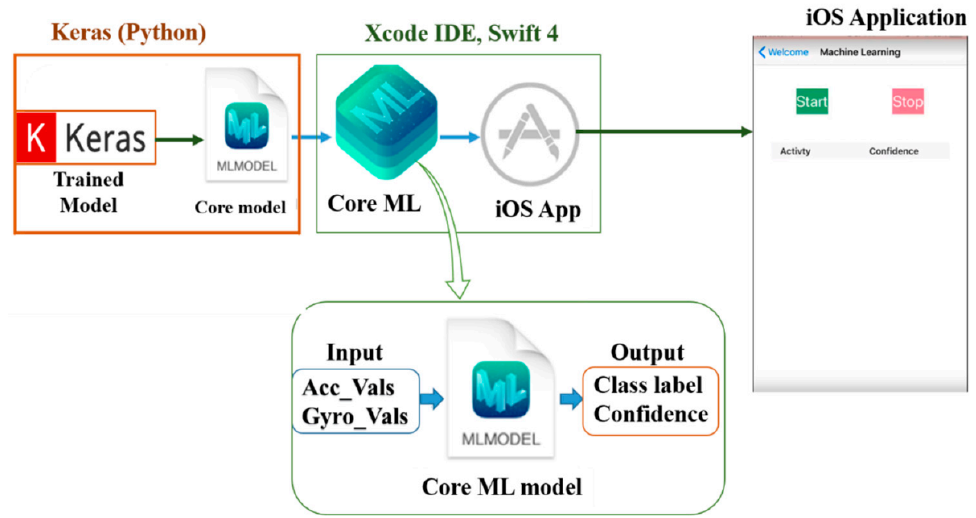
Figure 14. Integration of Keras model and the application.